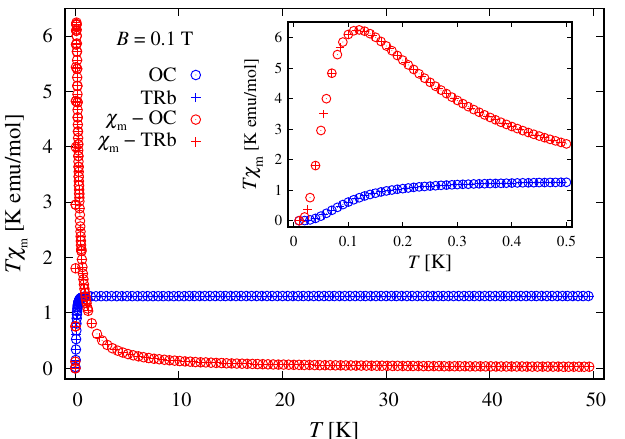
Figure 3. Simulated low-field molar susceptibility for the octahedral (OC) and trigonal bipyramidal (TRb) cases as a function of the temperature, with the parameter’s values specified at the end of Section 2.1. The ratio between the corresponding molar mass and density is taken as unity. The inset depicts the low-temperature domain.